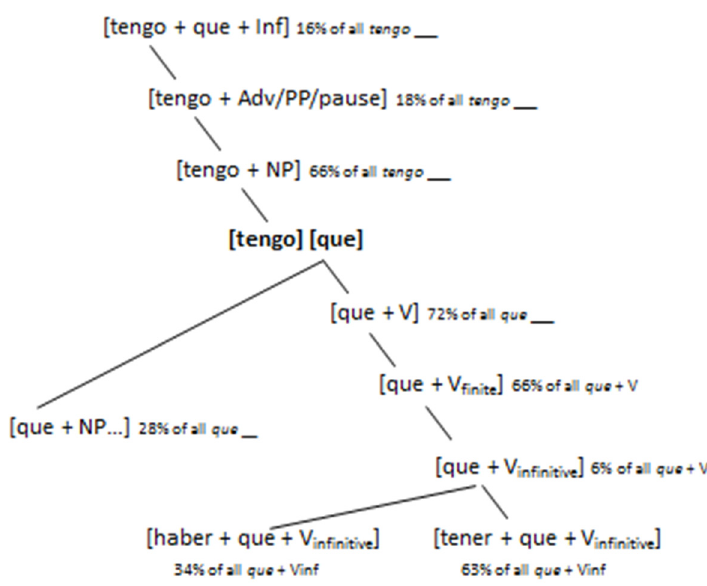
Figure 5. Diagram of links between construction components with their use in their constructions.